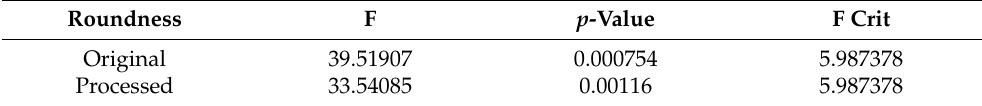
Figure 8. Comparison of roundness improvement after processing of low-precision three-lobe and multiple-lobe profiles. Table 10. One factor ANOVA of roundness of workpiece with the three-lobe